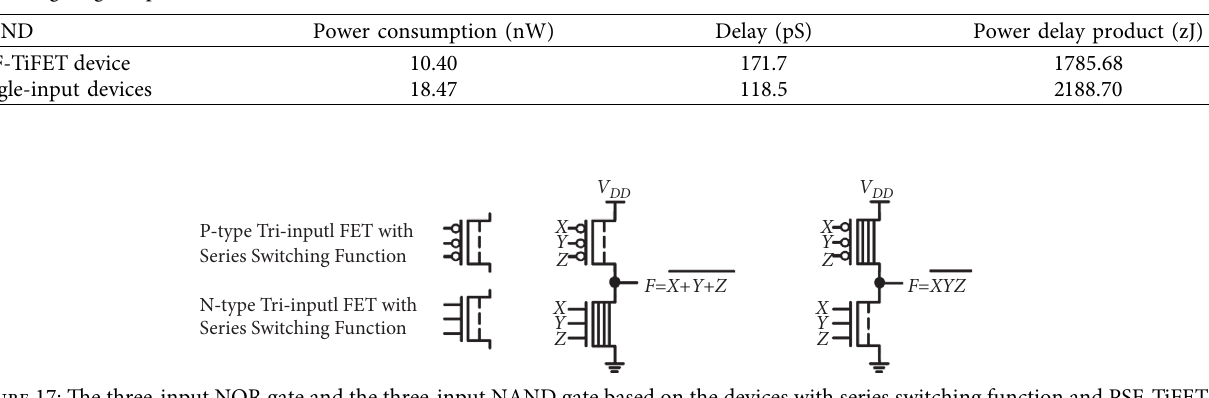
Figure 16: The simulated waveforms of the three-input NAND. Table 5: The power consumption, delay, and power delay product of the three-input NAND logic cell using PSF-TiFETdevice are compared with using single-input devices.